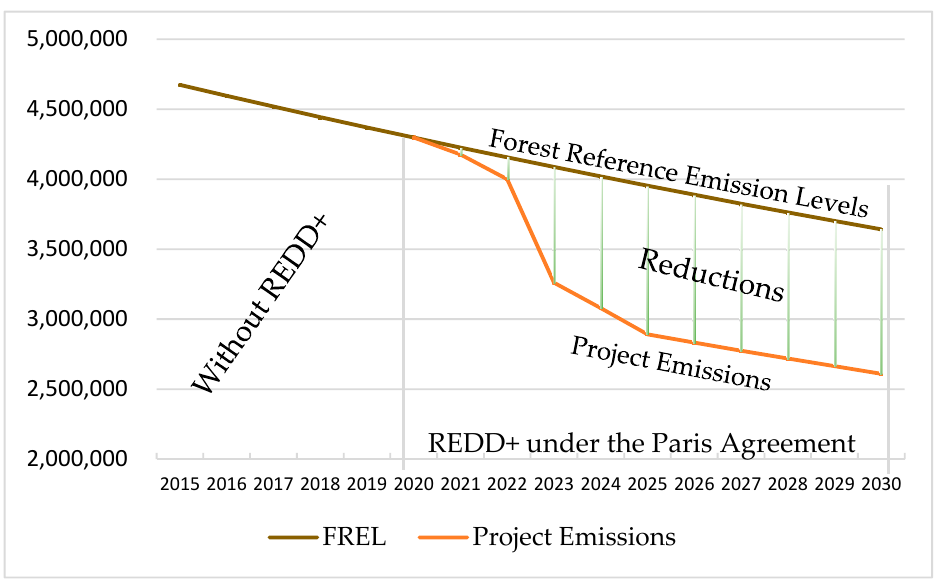
Figure 8. Forest reference emission levels and emission reductions in Siem Reap province during a 10-year project period (2020–2030). See Appendix A, Table A11 for total Forest reference emission levels (FREL) for Siem Reap province from 1990 to